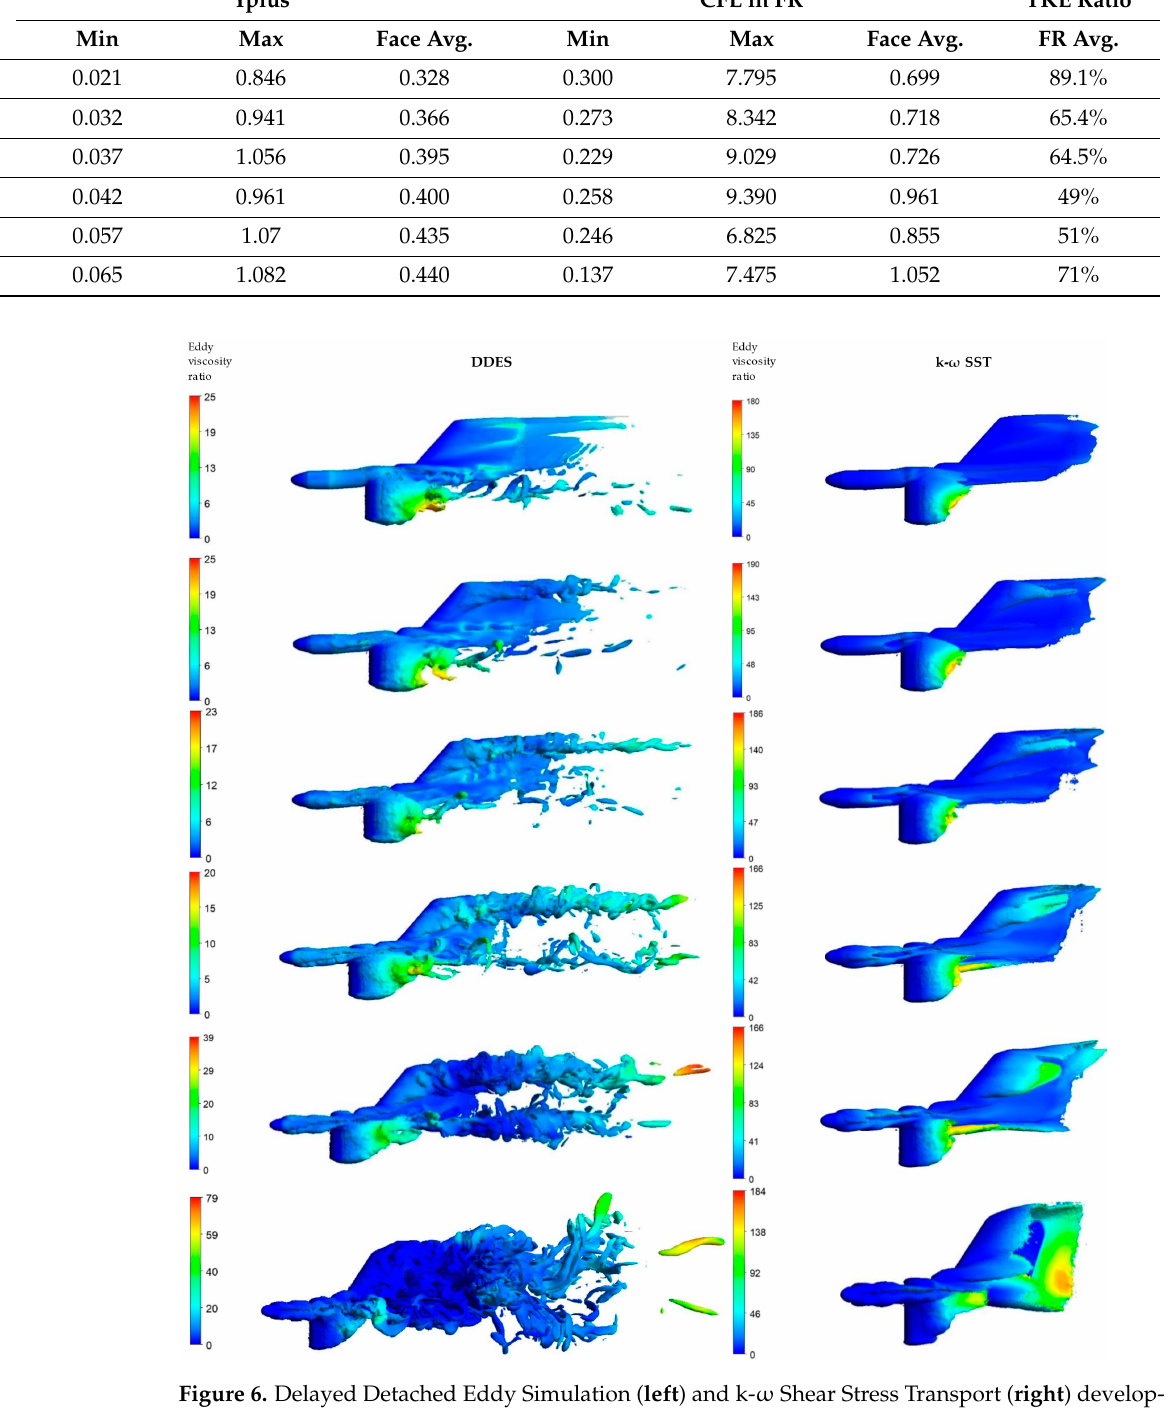
Figure 6. Delayed Detached Eddy Simulation ( left ) and k- ω Shear Stress Transport ( right ) develop- ment of vortex structure behind horizontal axis wind turbine’s vane, isosurface of vorticity colored by eddy viscosity ratio.